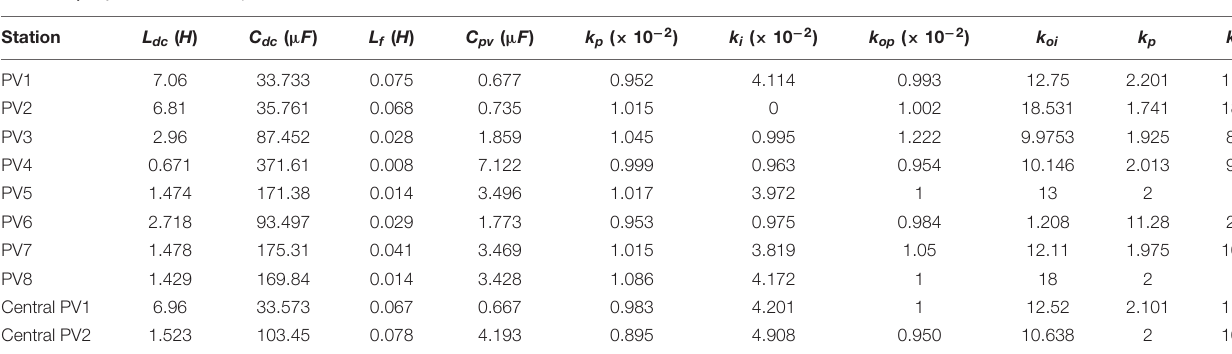
FIGURE 5 | Schematic diagram of the multiple PV stations system: (A) The original system, (B) The equivalent system. TABLE 1 | Physical and control parameters of PV